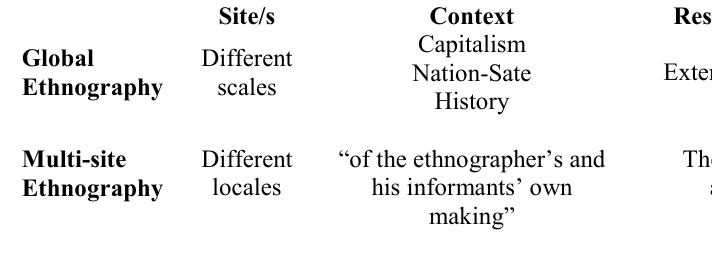
Table 1: GE and MSE Along Four Dimensions